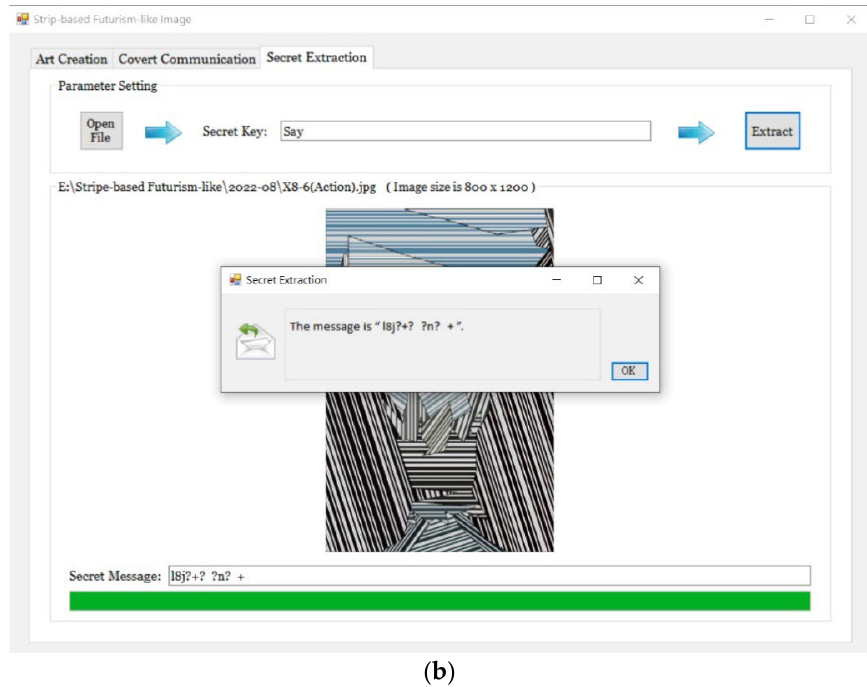
Figure 20. An illustration of extracting an erroneous secret message from the stego-image using an incorrect secret key “Say”. ( a ) The stego-image with the stripe width of 6 pixels shown in Figure 15e. ( b ) The erroneous hidden data extraction result.